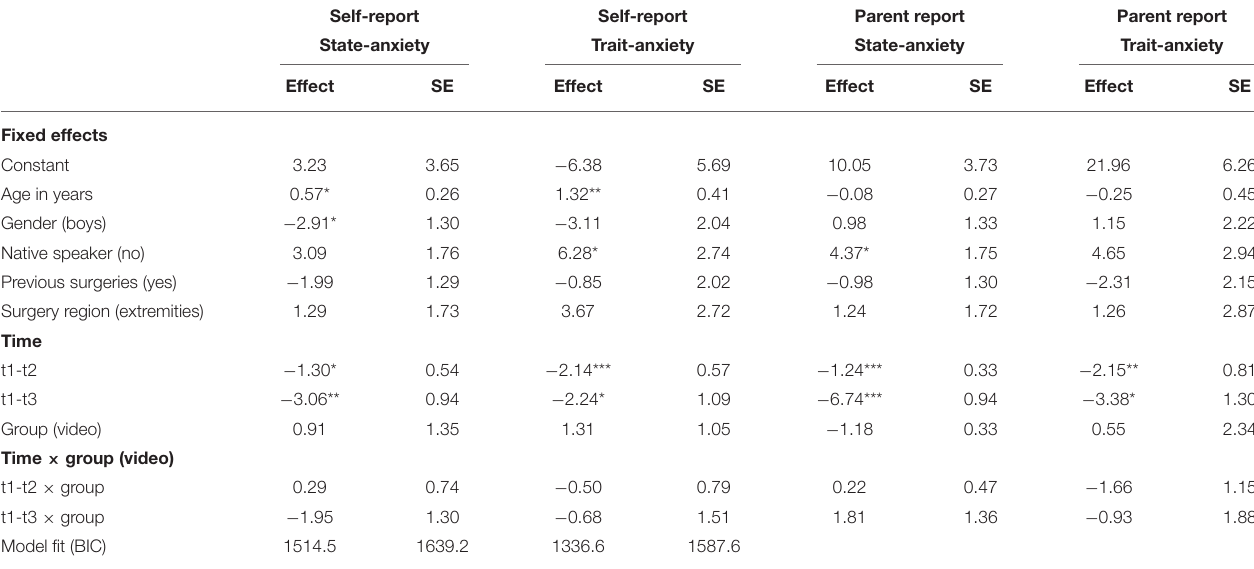
TABLE 3 | Prediction of surgery anxiety before (t1), after (t2) intervention, and after surgery (t3).